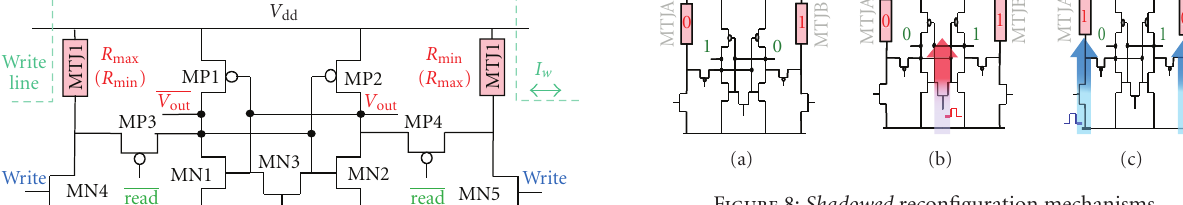
the parallel mode ( R p ), while R max is the resistance in the antiparallel mode ( R ap ).